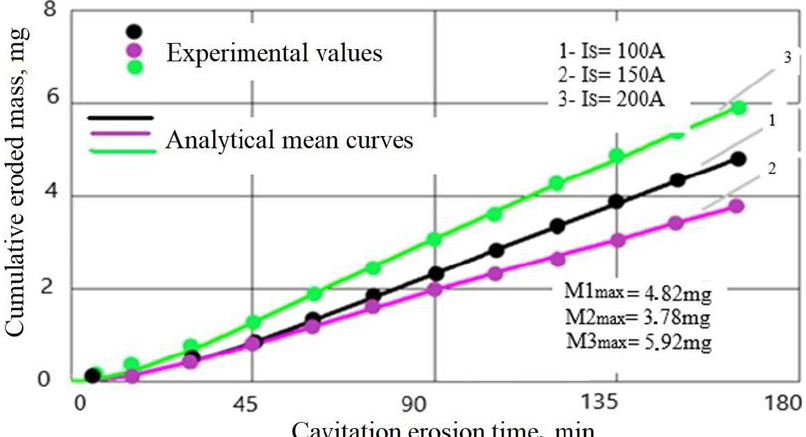
Figure 4. Mass losses of GX40CrNiSi25-20 steel at different remelting current intensities.